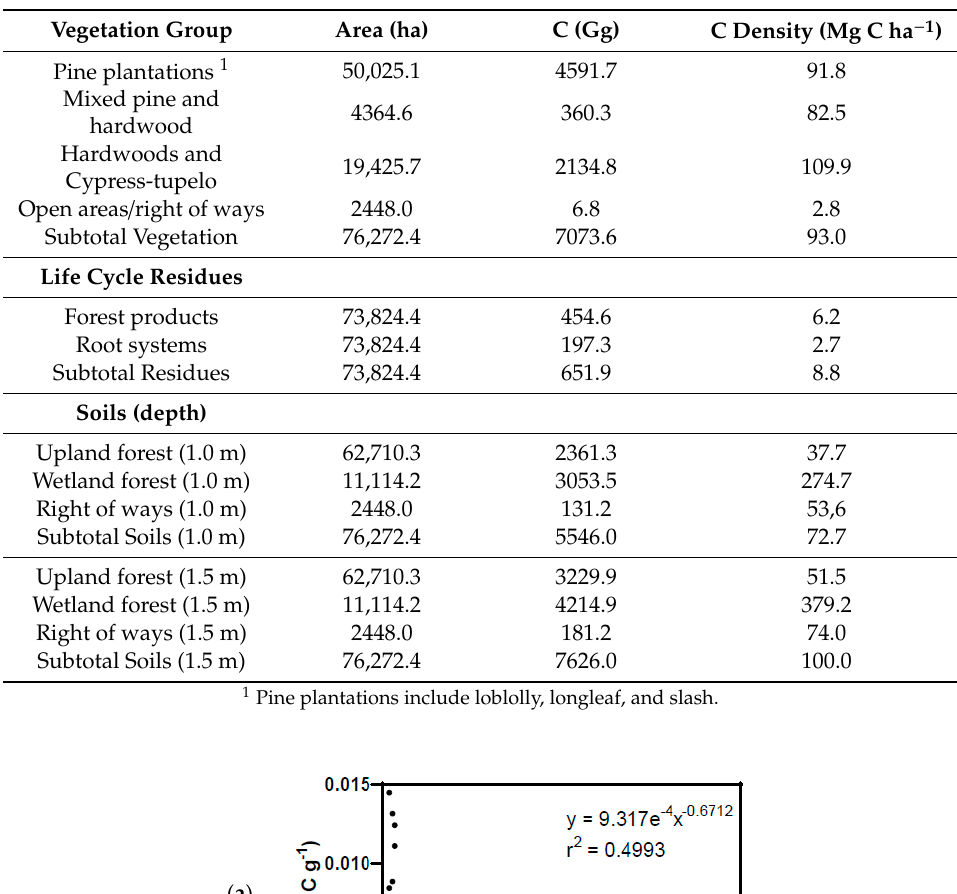
Table 6. Total C stored in vegetation and soil components in 2001 using Table 4 for the biomass, and the NRCS soil C values. Described in Section 2.4.